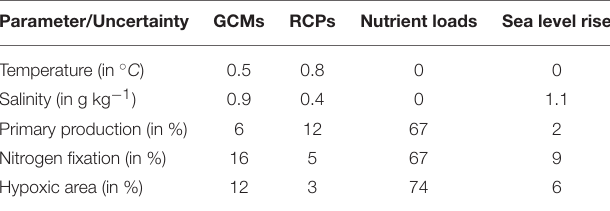
TABLE 3 | Uncertainties expressed as standard deviations in temperature and salinity and variances of 30 years mean changes between the future (2069–2098) and historical (1976–2005) climates in primary production, nitrogen fixation and hypoxic area caused by GCMs, RCPs, nutrient loads, and global mean sea level rise (only model A, BSAP, and Worst Case, see Table 2